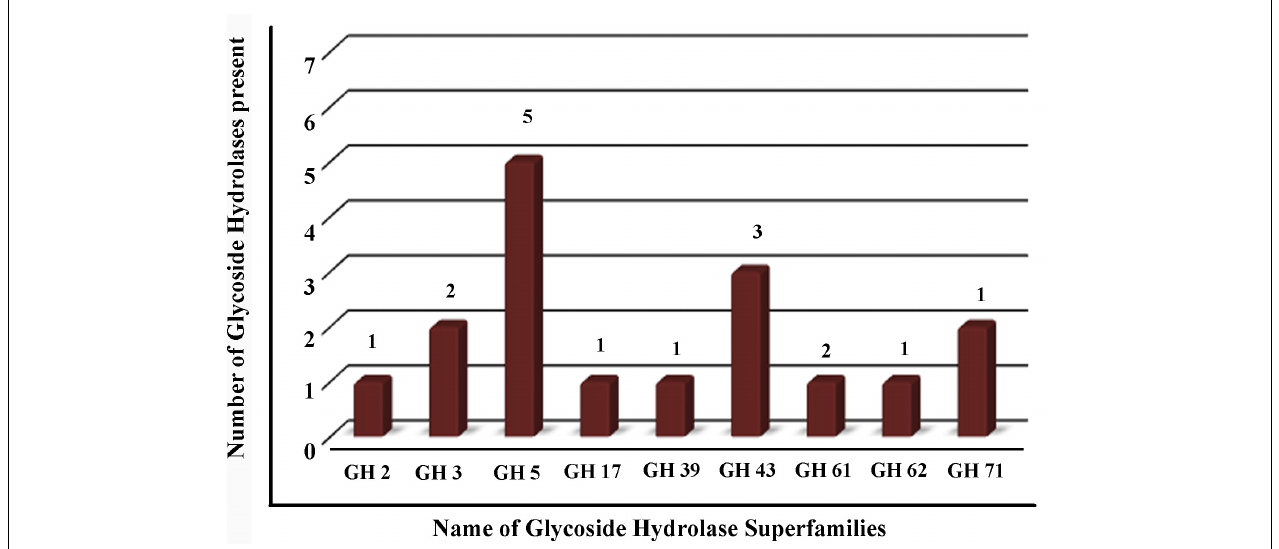
FIGURE 6 | Profile of glycoside hydrolases (GHs) found in the secretome proteins of M. phaseolina identified by LC-ESI-MS/MS. Bar graph shows the distribution of 17 GHs identified by LC-ESI-MS/MS. Nine different types of GHs were found in multiple numbers in the secretome proteins of M. phaseolina